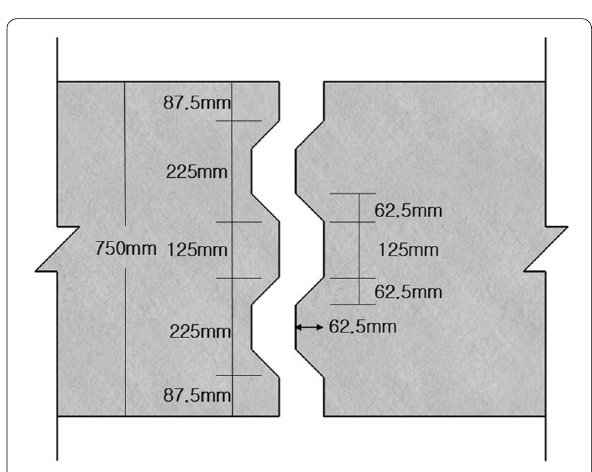
Fig. 3 Details of shear